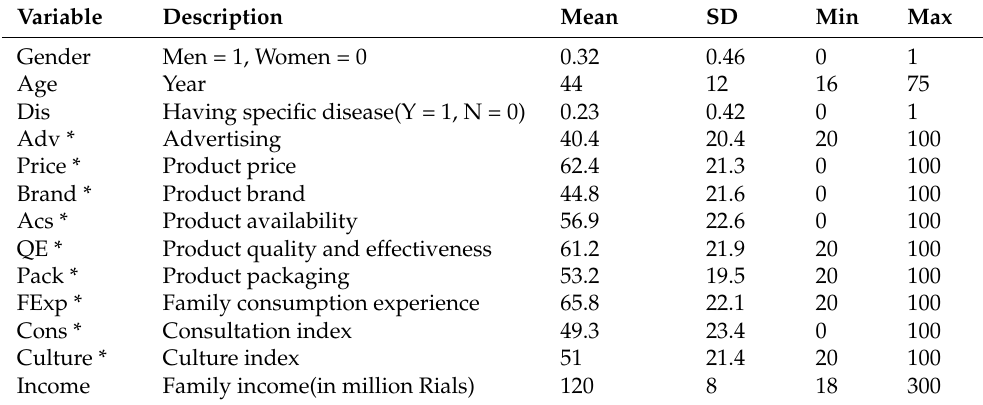
Table 2. Descriptive statistics of independent